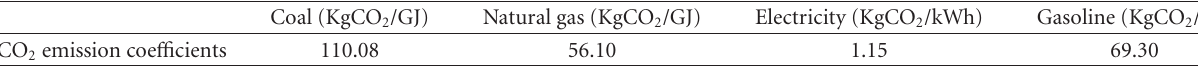
Table 1: The CO 2 emissions factors of conventional energy.